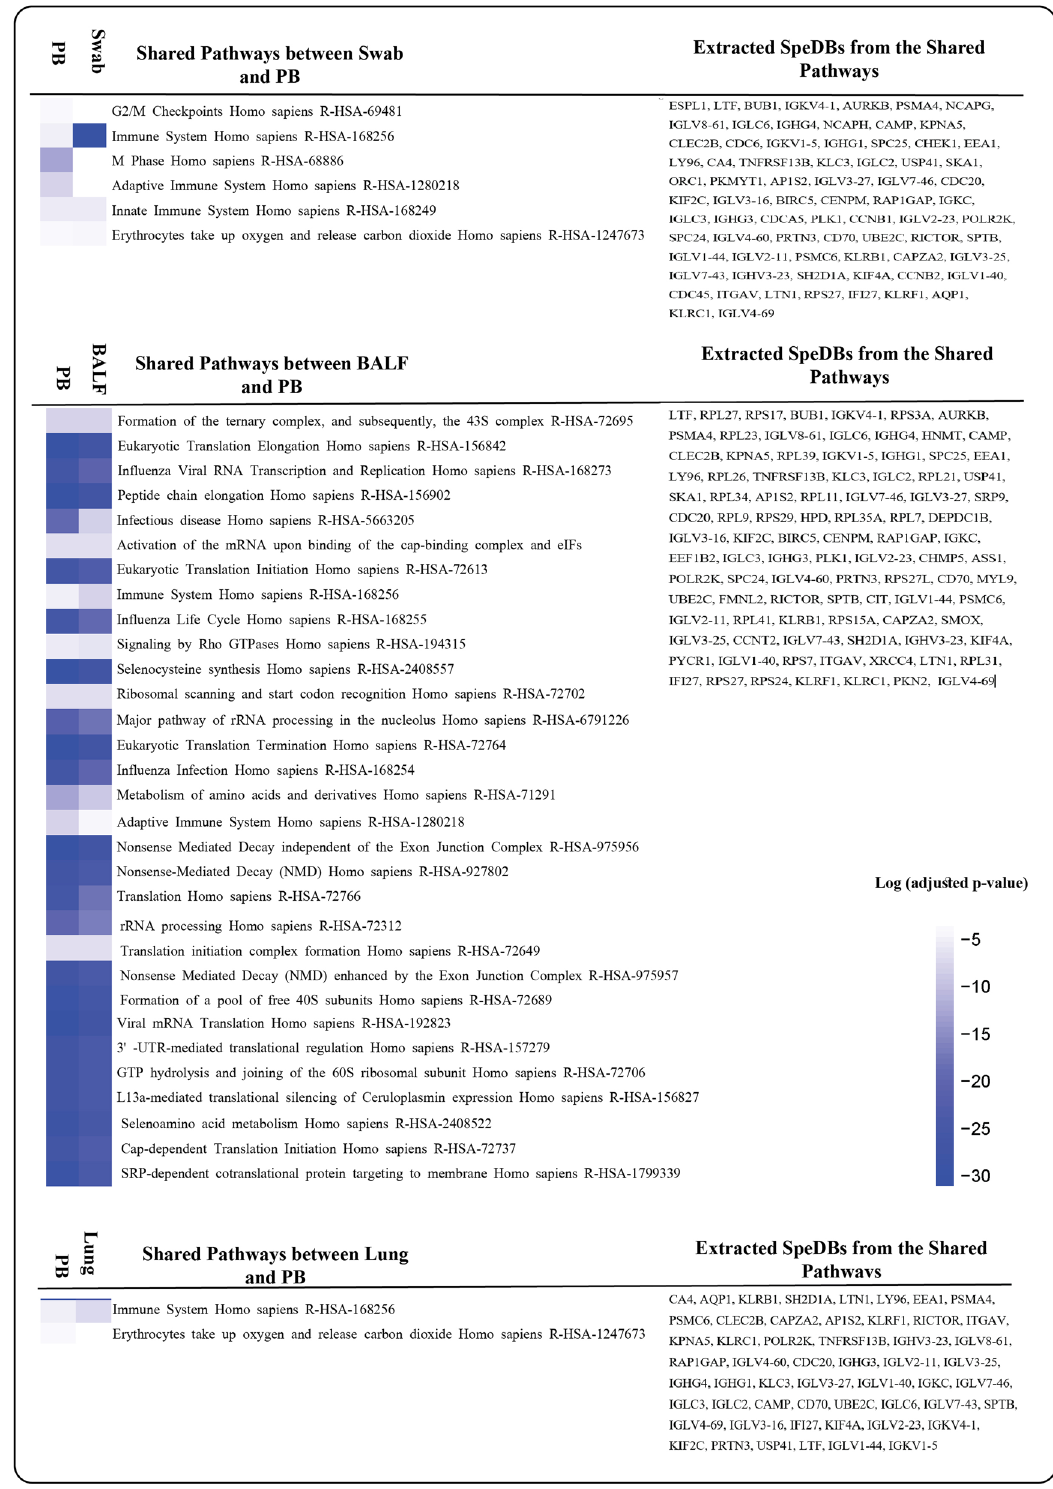
Figure 2. Common Pathways of PB with BALF, Lung, and Swab, their adjusted p-values in pathway enrichment analysis, and the list of extracted SpeBDs from them. The figure is generated using RStudio version 2022.12.0 and Adobe Illustrator version